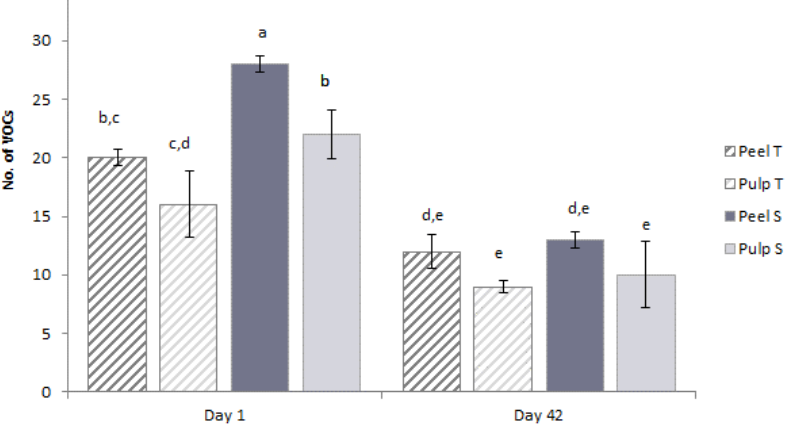
Figure 7. The dynamics of VOCs in T and S coated zucchinis’ peel and pulp during storage. Different letters indicate significant differences with ANOVA and Tuckey post-hoc test at p < 0.05